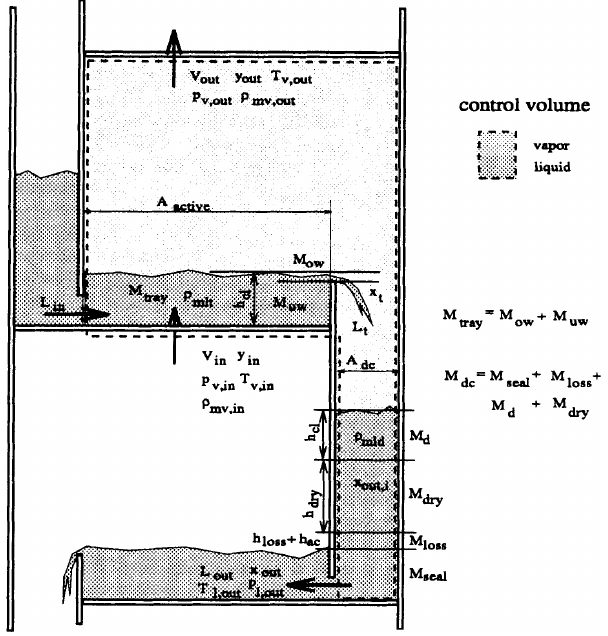
Figure 1. Typical design of a staged distillation column with sieve tray and